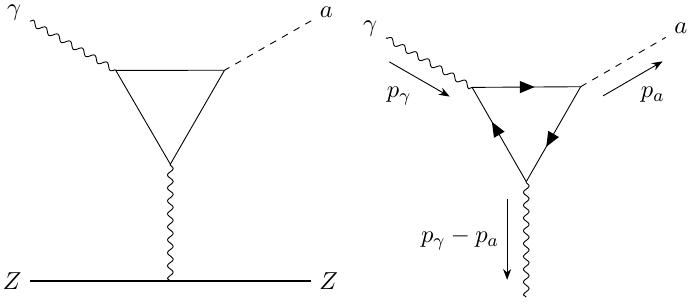
Figure 11 . Left : Feynman diagram of the Primakoff production process via a fermion loop. Right : Feynman diagram of the amplitude we need to calculate to replace g production